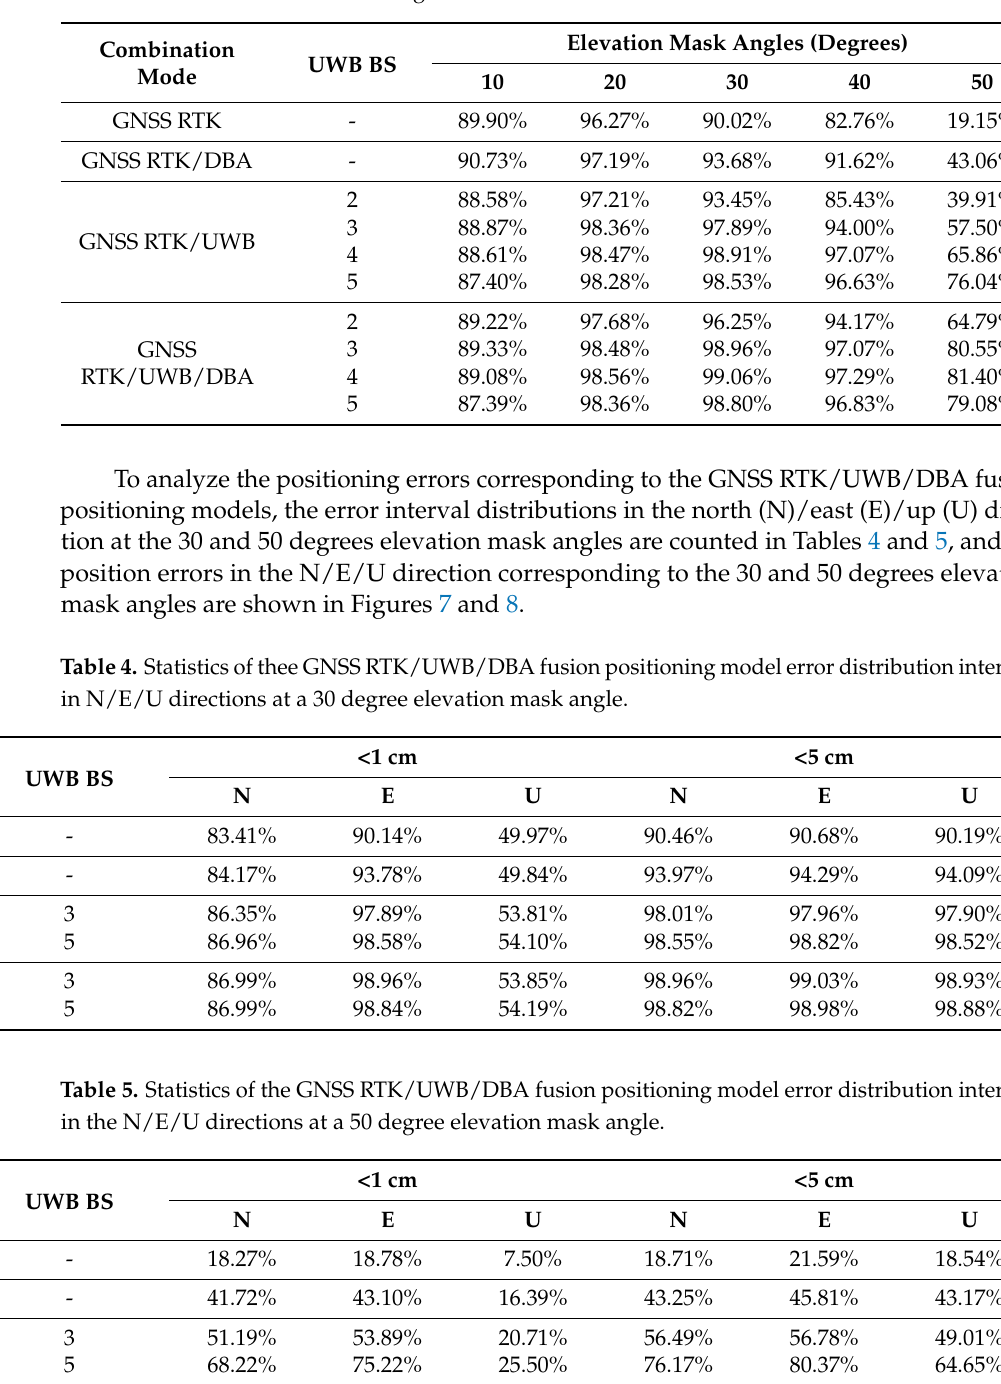
Table 3. The ambiguity resolution success rate of the GNSS RTK/UWB/DBA fusion positioning model at various elevation mask angles in a static environment.